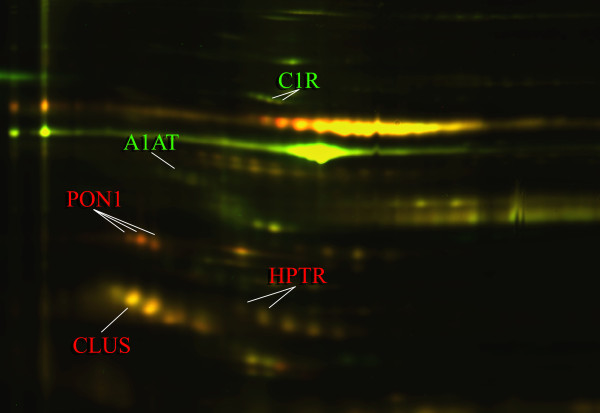
 Representative section of the 2D-DIGE proteome map of basal and after the ω-3 PUFAs supplementation. Proteins were labeled with Cy3 (basal situation) and Cy5 (after the ω-3 PUFAs supplementation). An internal standard comprised of equal amount of proteins from all samples (basal and after the treatment) was labeled with Cy2 and included in all gels. The green spots indicate downregulated proteins, while the red spots indicate upregulated proteins after the ω-3 PUFAs supplementation. Some of the most representative identified proteins that showed significantly altered expression after ω-3 PUFAs supplementation are indicated with arrows and labeled with the respectives protein entry name.